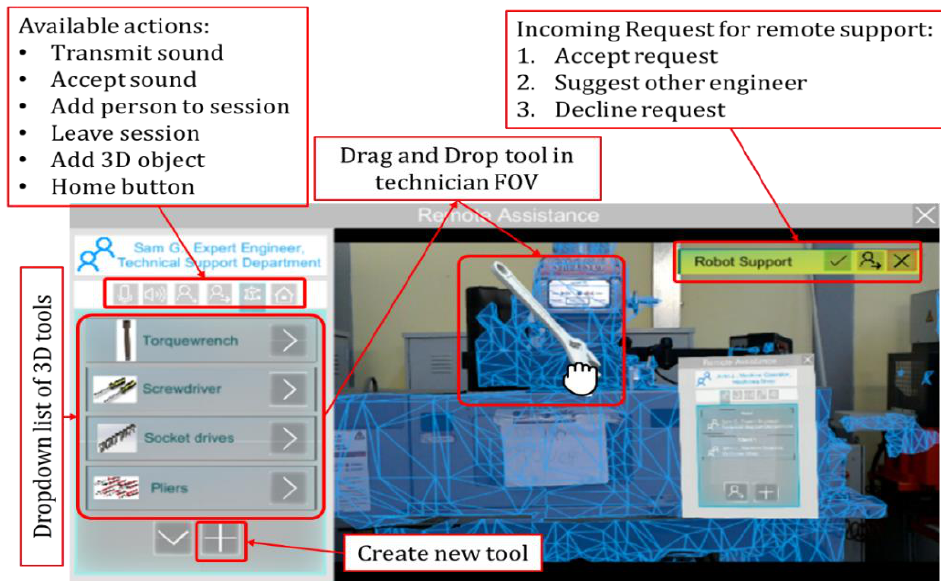
Figure 3. GUI for online maintenance session.